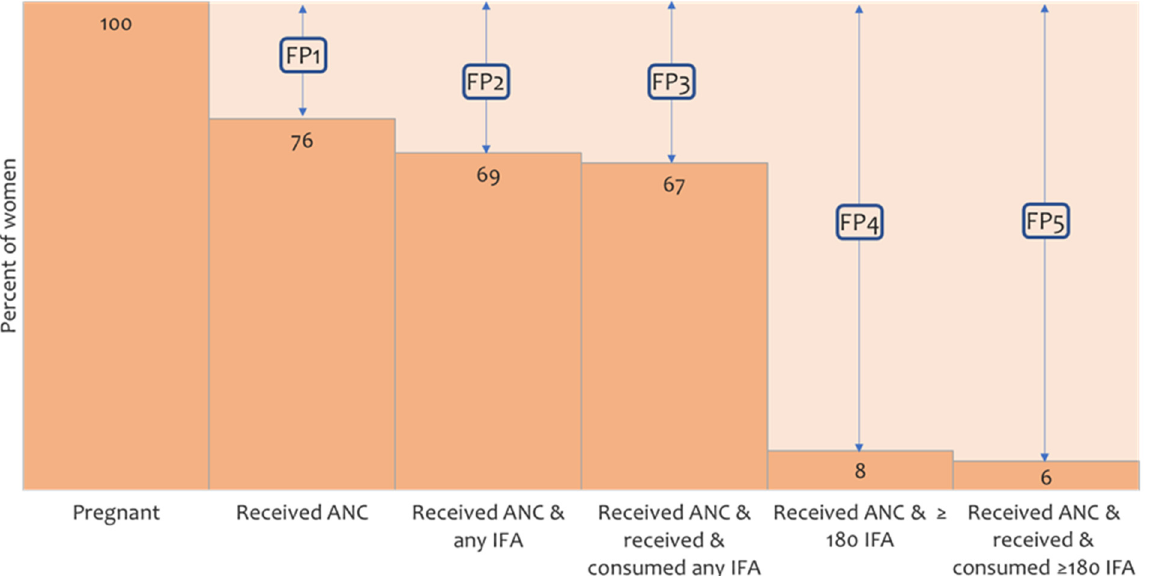
Figure 3. The five falter points (FP) in user adherence-adjusted coverage of IFA supplementation (consumption of ≥ 180 IFA). FP1—falter in receiving ANC, FP2—falter in receiving any IFA, FP3—